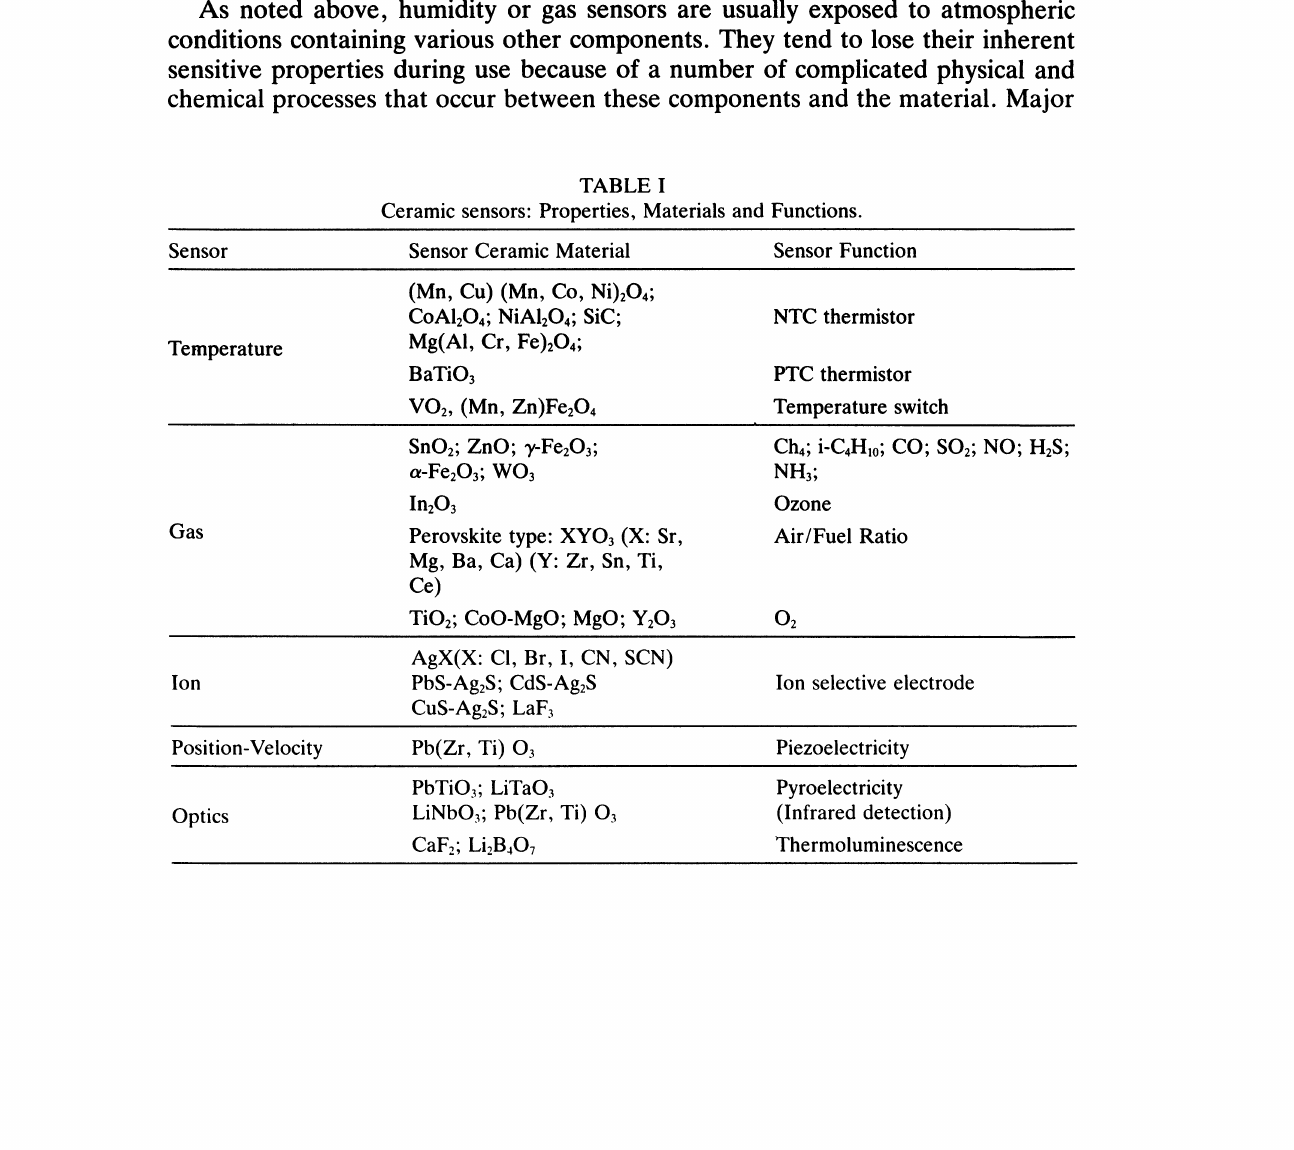
Ceramic sensors: Properties, Materials and